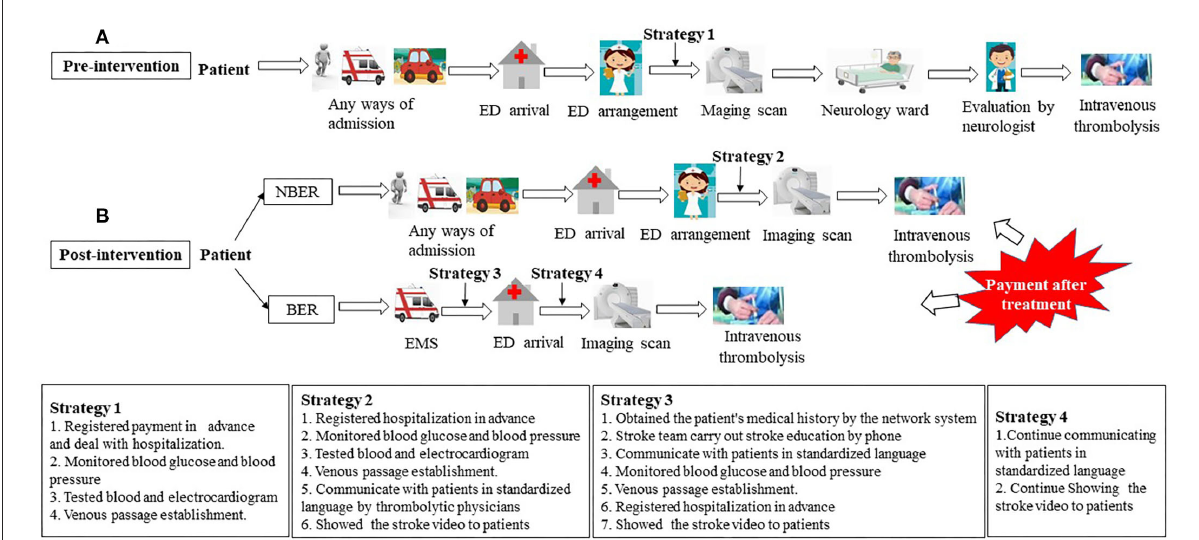
FIGURE1 Pre-intervention and post-intervention processes for intravenous thrombolysis in AIS patients. (A) Pre-intervention processes for intravenous thrombolysis in AIS patients; (B) Post-intervention processes for intravenous thrombolysis in AIS patients. ED, emergency department;